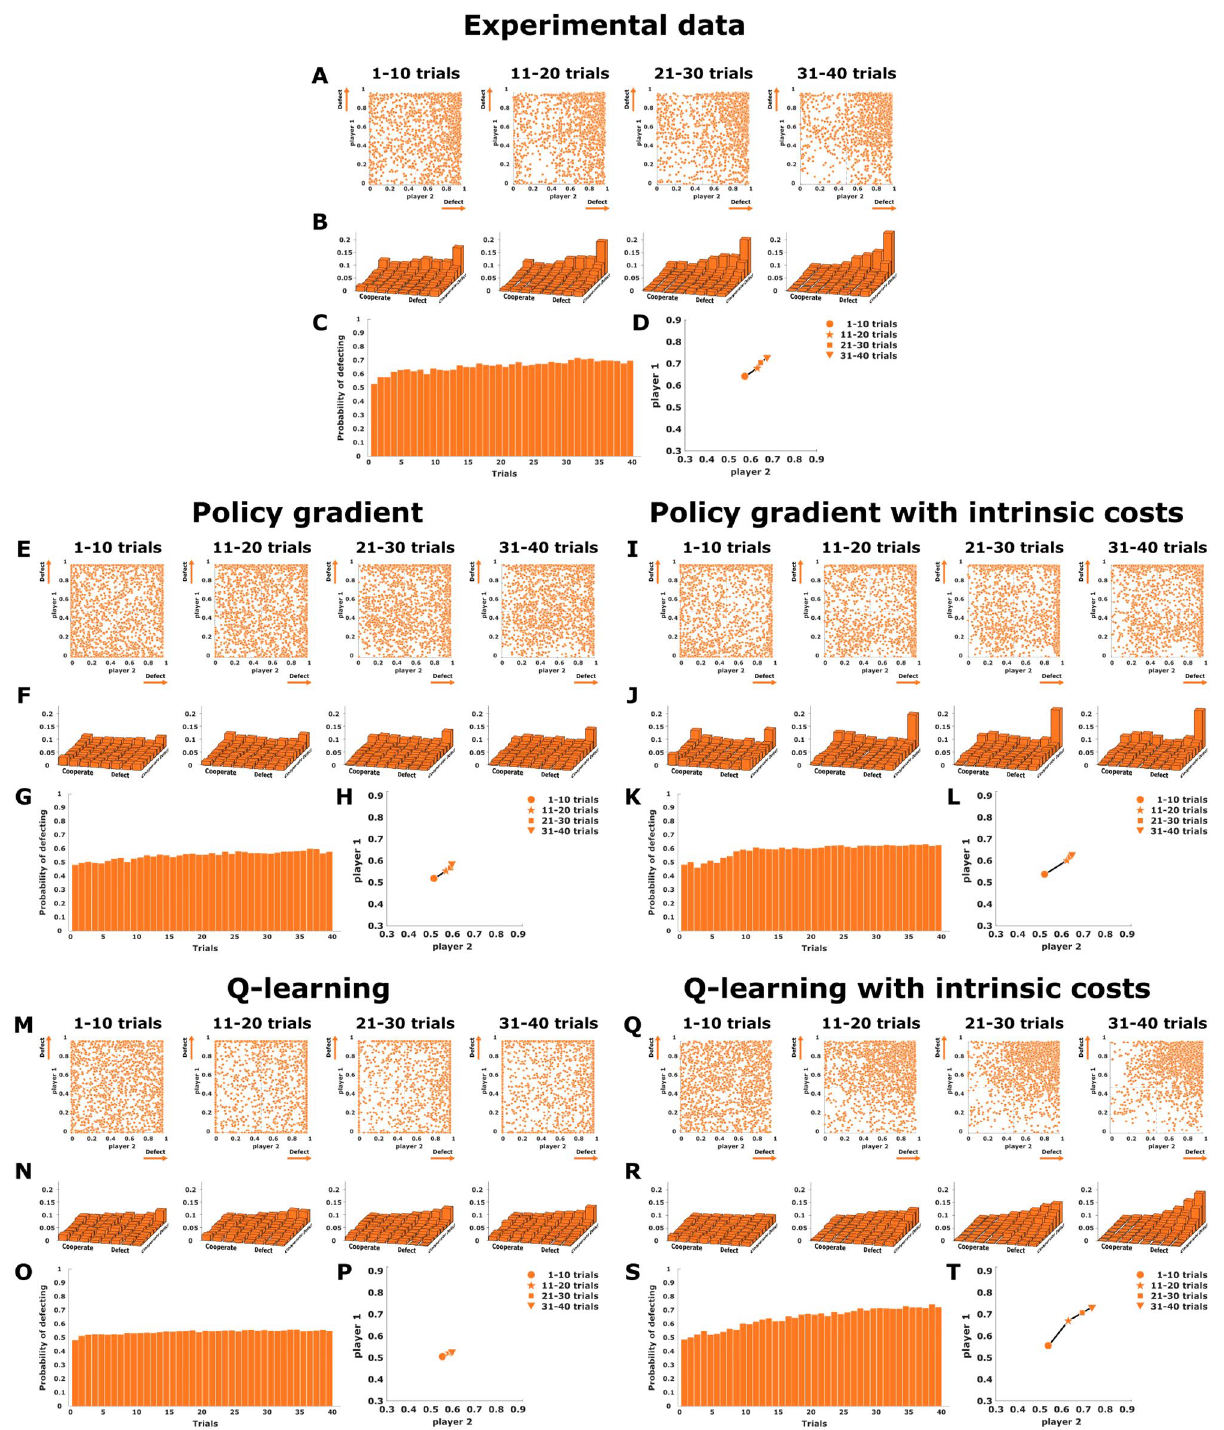
Figure 3. Prisoner’s dilemma. ( A ),( E ),( I ),( M ), and ( Q ) show scatter plots of final decisions in the x 1 x 2 -plane, where subjects’ actions are expected to cluster around the single pure Nash equilibrium located in the top-right corner at position (1,1). ( B ),( F ),( J ),( N ), and ( R ) show two-dimensional histograms binning the experimental scatter plots. ( C ),( G ),( K ),( O ), and ( S ) represent the change of the mean endpoints (averaged for both players) for each trial across the block of 40 trials. ( D ),( H ),( L ),( P ), and ( T ) show the direction of adaptation in the endpoint space. The experimental data is shown at the top, the four continuous models are shown below. Created using MATLAB R2021a (https:// www. mathw orks. com) 43